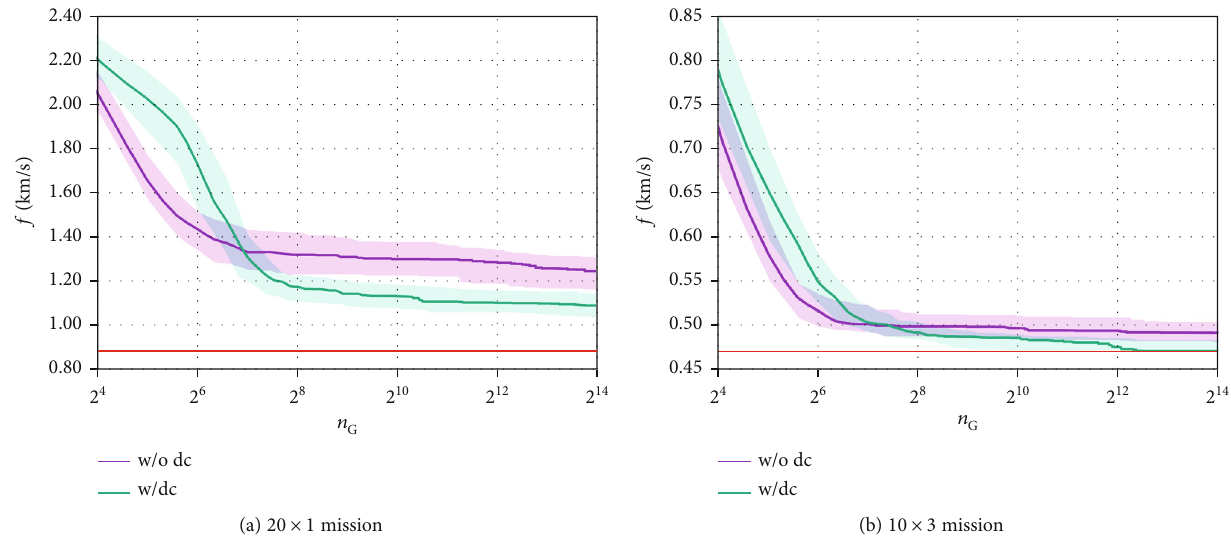
Figure 11: Median fi tness and interquartile range along the evolution process with and without the diversity control. The population size is n = 64 . The optimal fi tness f ⋆ (red line) is reported for comparison. P